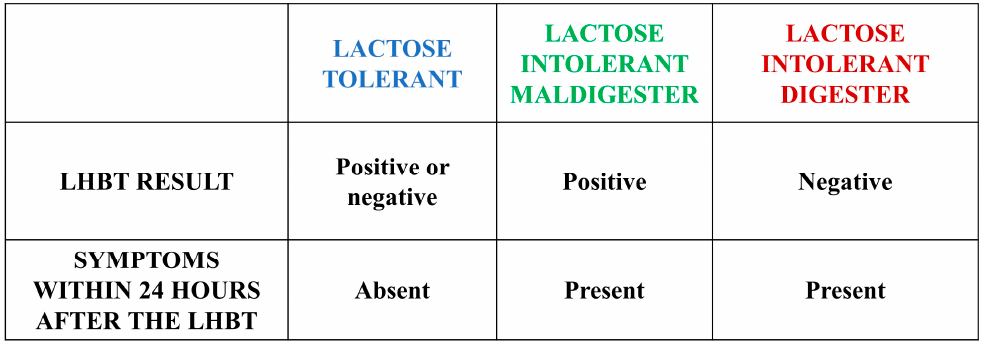
Figure 1. Characteristics of the three subgroups.